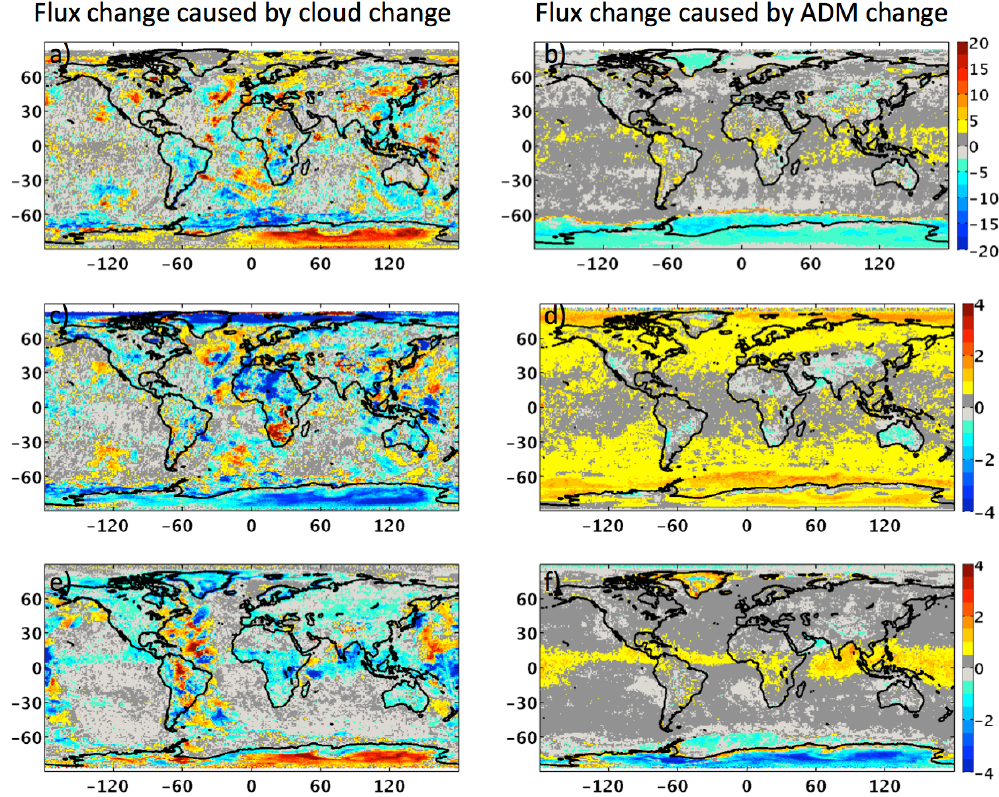
Figure 18. Instantaneous flux differences caused by changes in cloud algorithms (left panels, Ed4SSF β -Ed2SSF ) and by changes in ADMs (right panels, Ed4SSF-Ed4SSF β ): (a) and (b) for SW, (c) and (d) for daytime LW, and (e) and (f) for nighttime LW, using Terra measurements of October 2002.